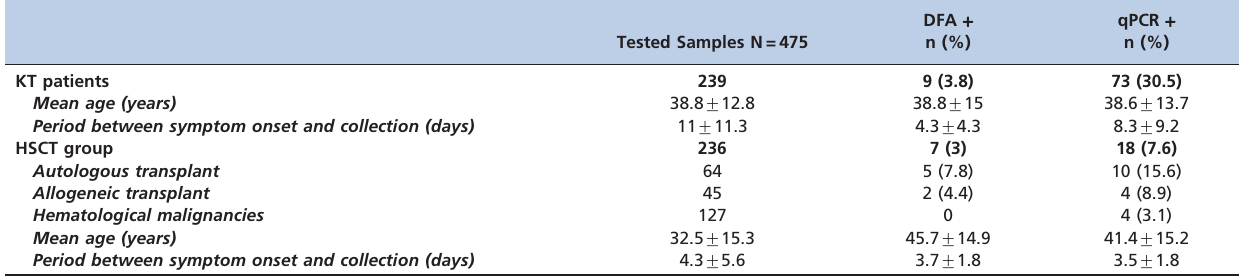
Table 1 - Epidemiological and clinical characteristics and influenza detection by DFA and qPCR according to patient